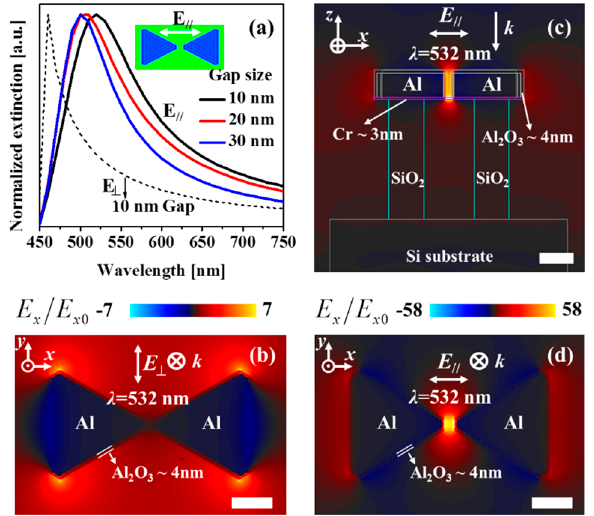
Figure 4. Simulated optical response and electric field distributions around Al bowtie excited at 532 nm wavelength. ( a ) Extinction spectra of the Al bowtie antennas at two different polarization conditions: parallel to the bowtie axis with different gap size of 10 nm, 20 nm, 30 nm (solid curves), and perpendicular to the bowtie axis with a 10 nm gap (dashed curve). The electric field distributions around a 105-nm-length, 10-nm-gap Al bowtie array excited at the 532-nm wavelength are simulated with two polarized excitations: ( b ) Perpendicular polarization, ( c ) and ( d ) parallel polarization with side-view and top-view, respectively. The scale bar is 50 nm for all panels (b), (c) and (d). The electric field hot-spot shows a strong electric field confinement with an enhancement factor | E x / E x0 | of 58, where E x and E x0 are the amplitudes of the enhanced and incident electric fields, respectively.